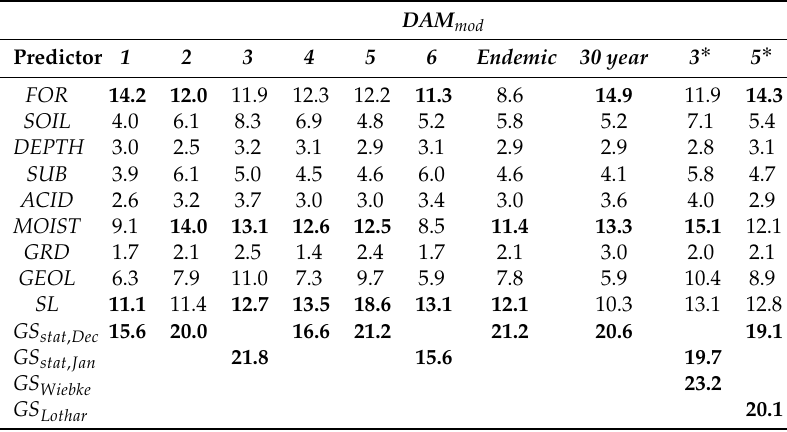
Table 3. Predictor importance ( PI ) of random forests model outputs for proportions of storm damaged timber ( DAM mod ) Top three important predictor variables are marked bold.